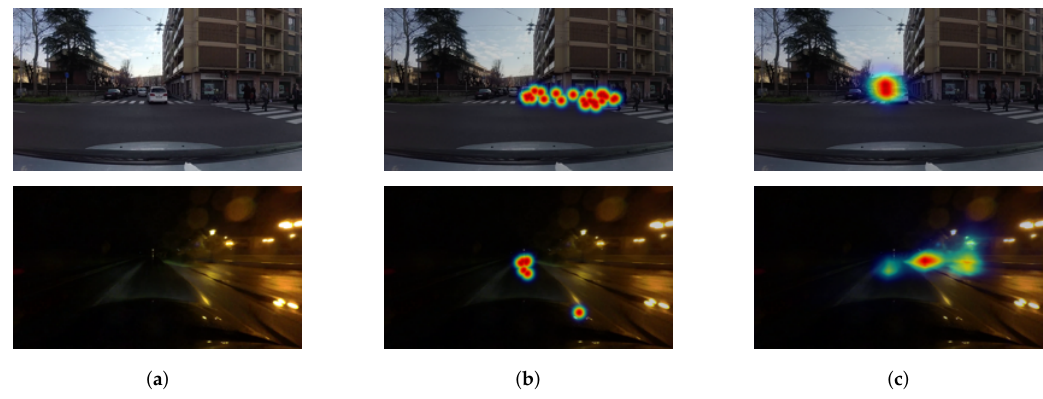
Figure 2. Example of failure case. ( a ) Input image. ( b ) Ground-truth attention map. ( c ) Predicted attention map. The predicted map failed to detect pedestrians on the crosswalk and traffic signs and localize the detected attention